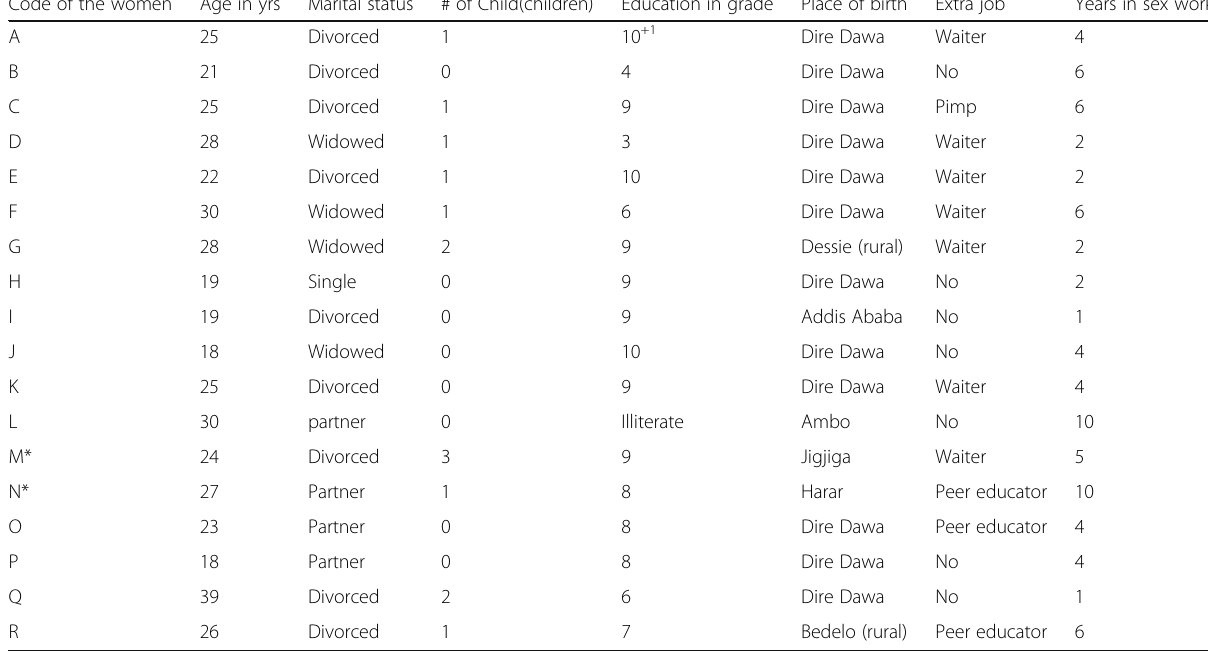
Table 1 socio demographic and other characteristics of study participant FSWs, 2016 Code of the